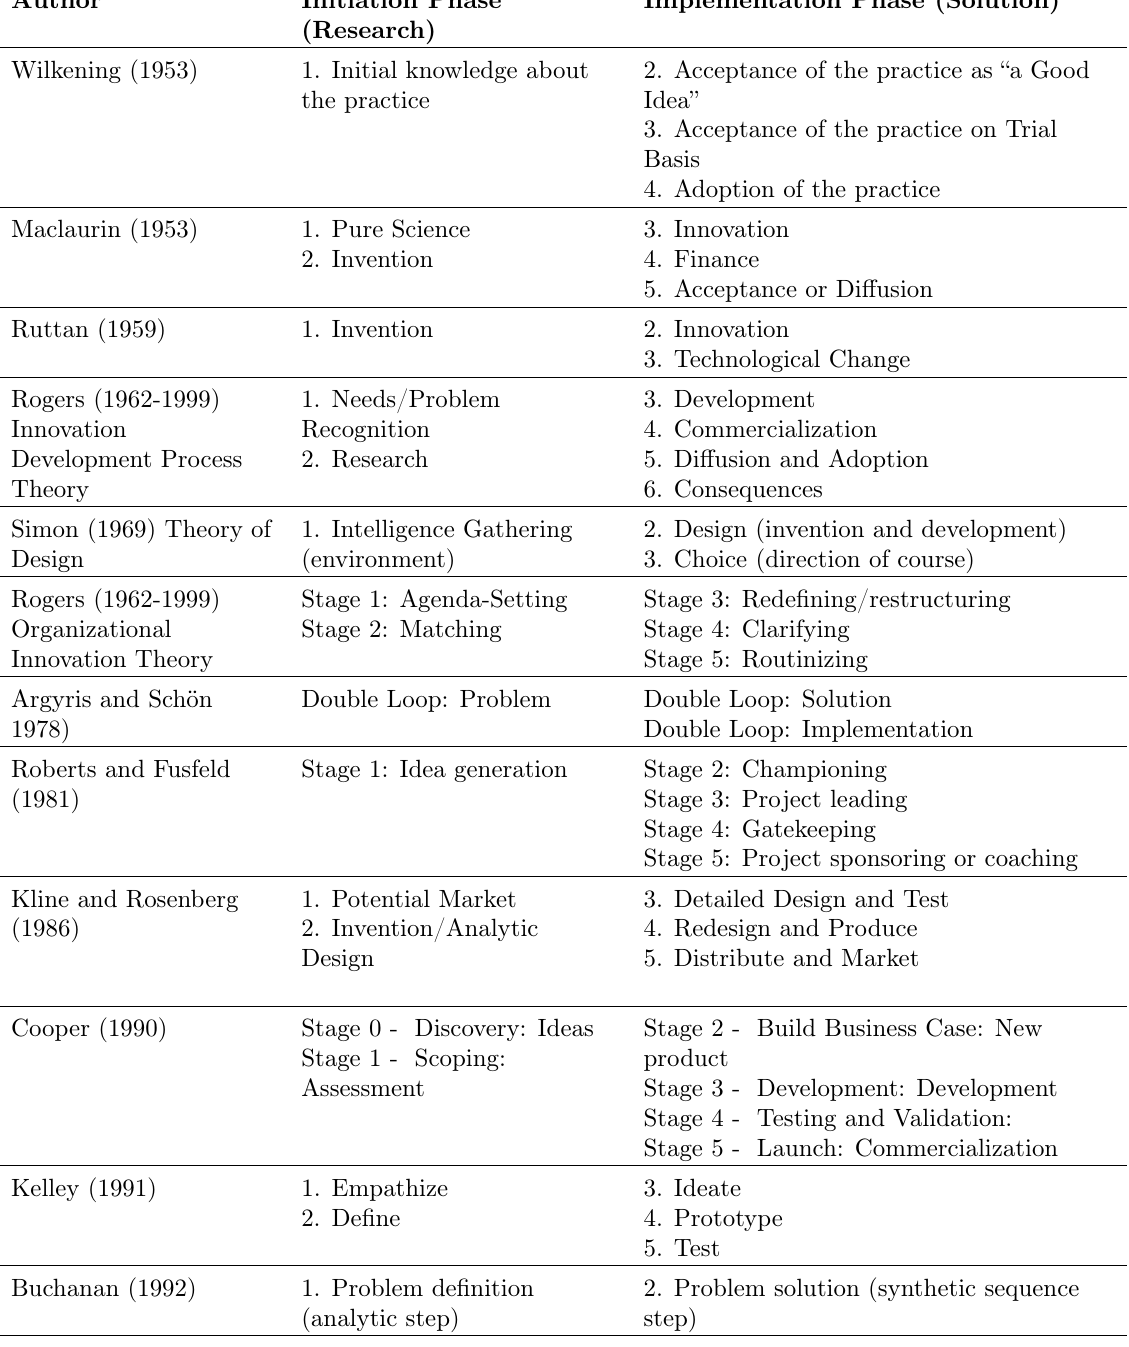
Table 2. Classification of innovation process models mapped across two key